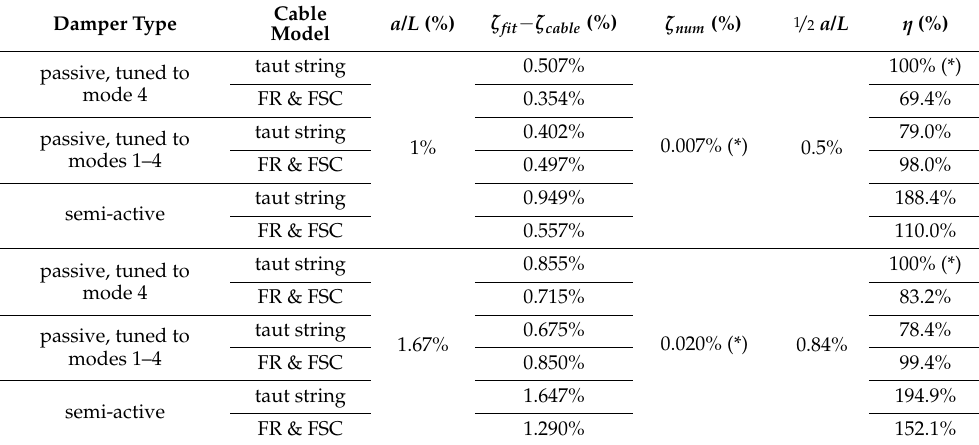
Table 4. Results for mode 4